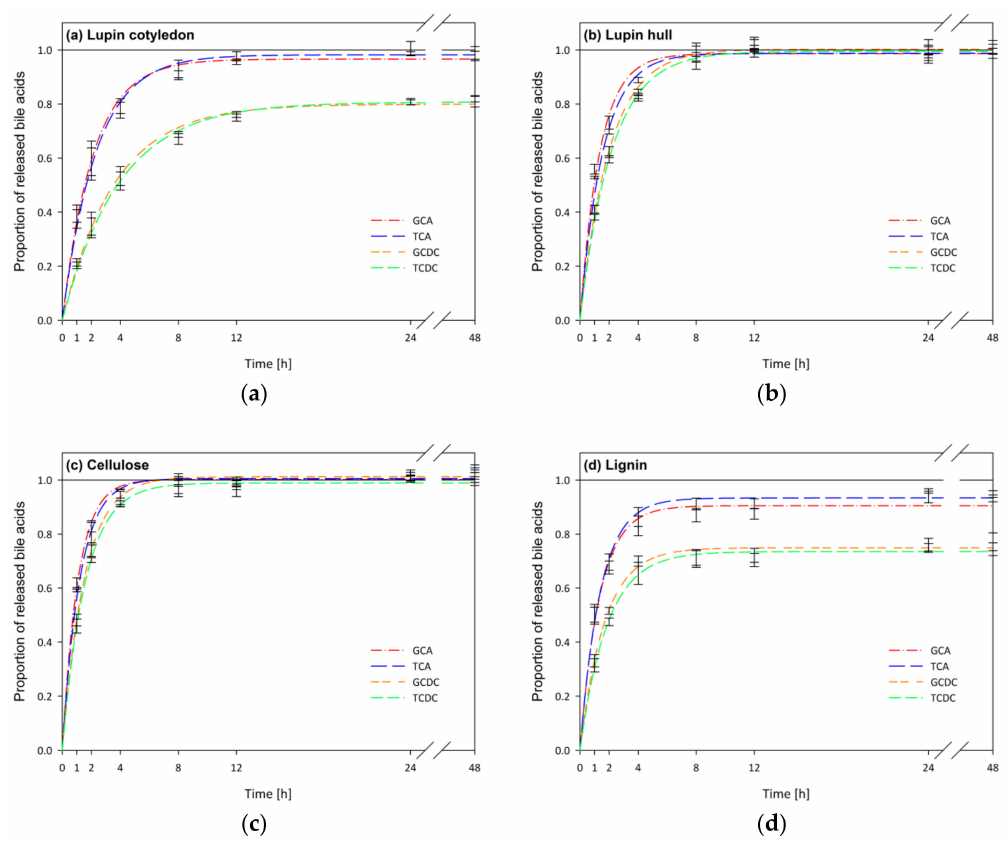
Figure 6. Di ff usion kinetics of bile acid release (glycocholic acid (GCA), taurocholic acid (TCA), glycochenodesoxycholic acid (GCDC), and taurochenodesoxycholic acid (TCDC)) of in vitro digested cotyledon ( a ) and hull ( b ) of L. angustifolius L. Boregine, cellulose ( c ) and lignin ( d ) ( n =